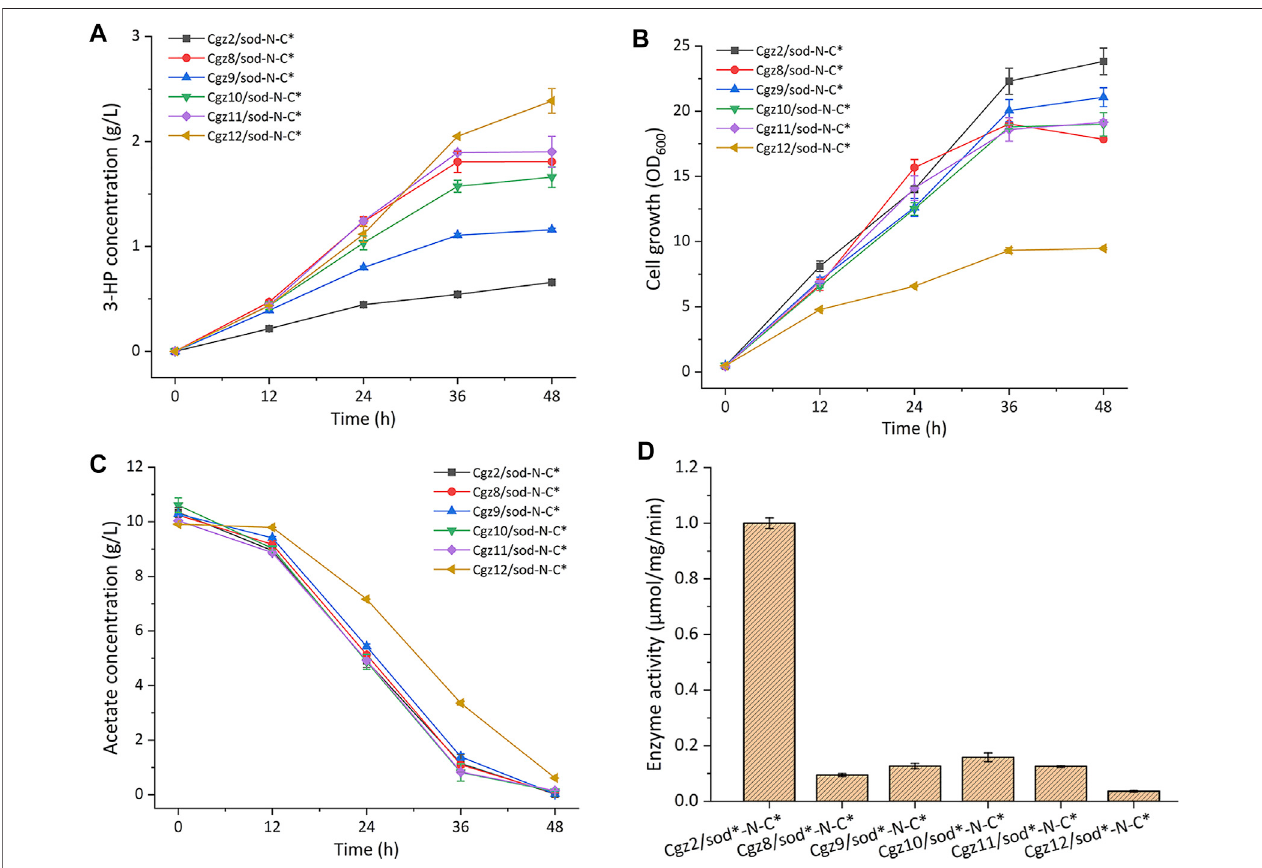
FIGURE 3 | Characterizations of citrate synthase (CS) modi fi ed recombinant strains. (A) 3-HP production, (B) cell growth (OD 600 ), (C) acetate consumption, and (D) CS enzyme activities.